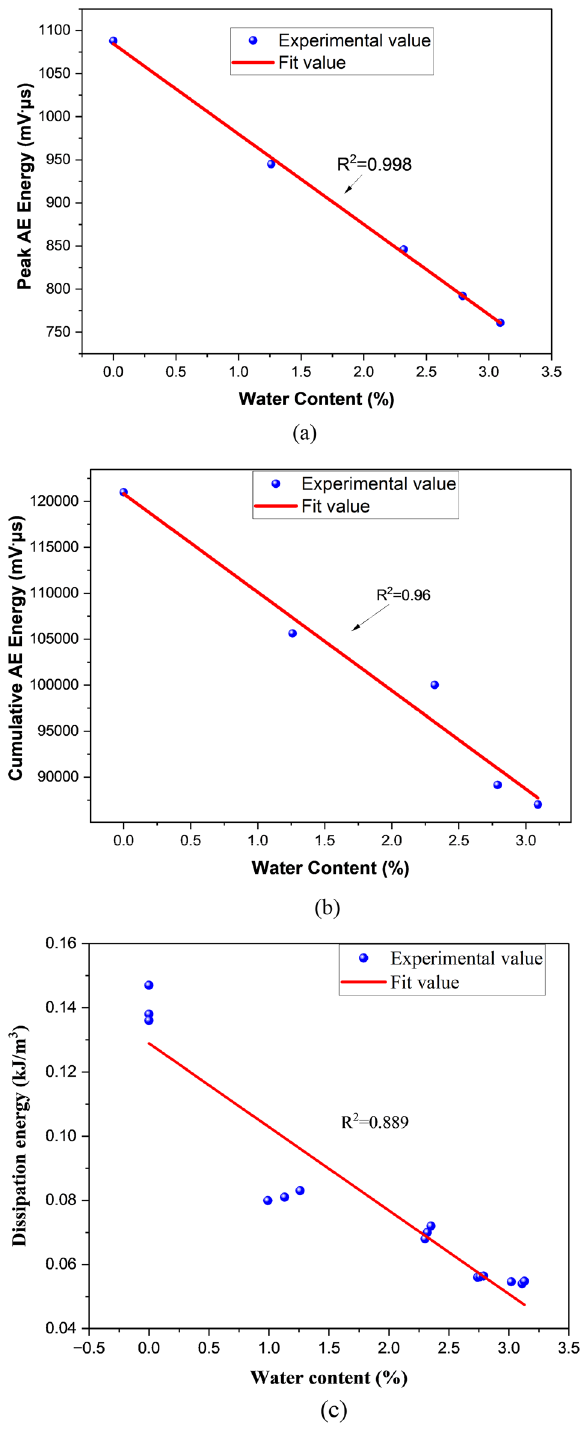
Figure 9. The correlation of water content with ( a ) peak AE energy ( b ) cumulative AE energy ( c ) dissipation